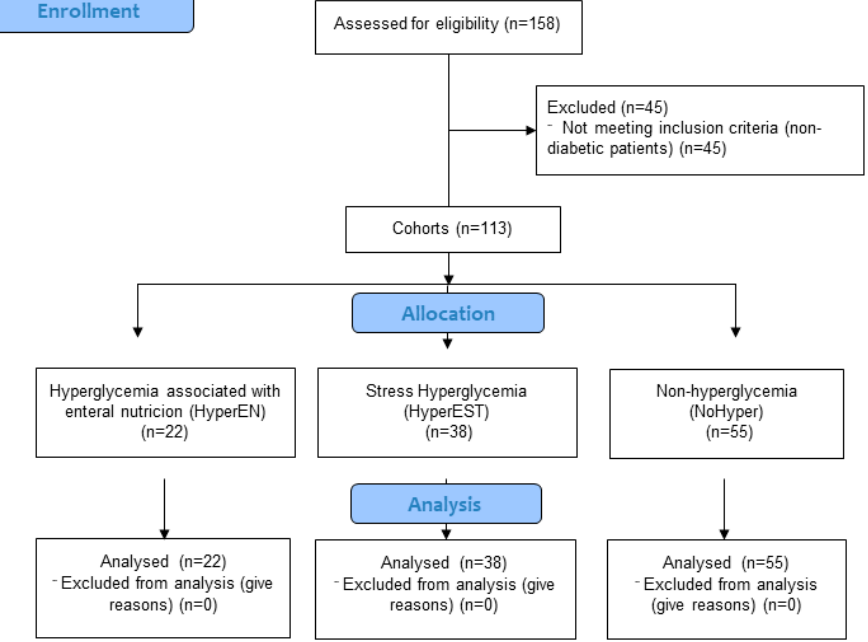
Figure 1. Flow chart of the distribution in cohorts of patients.